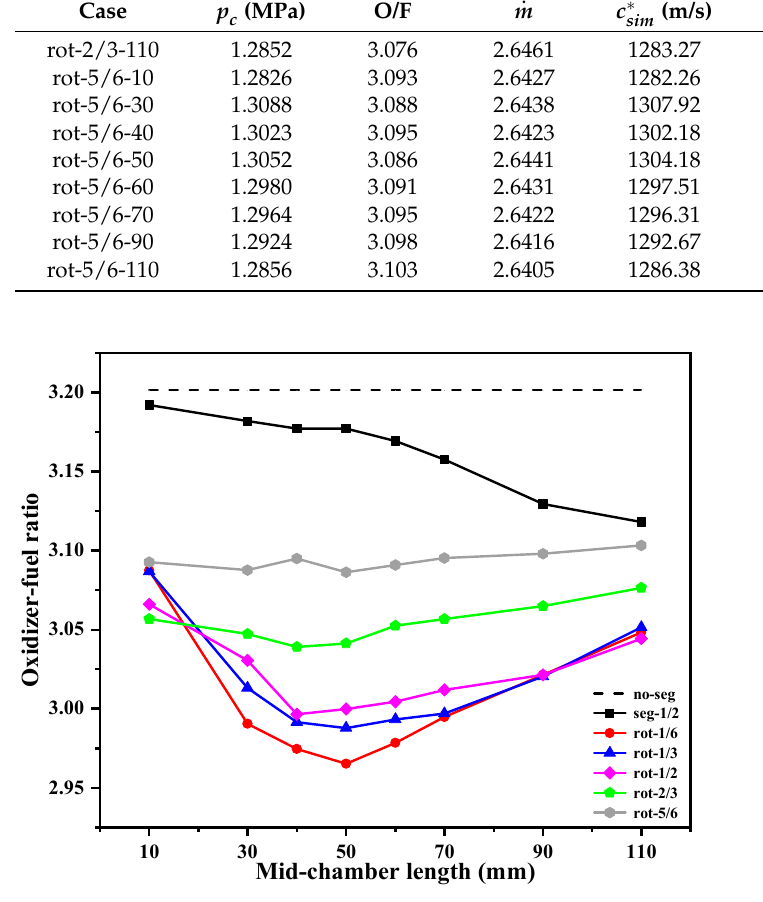
Figure 28. Oxidizer to fuel ratio in various cases.